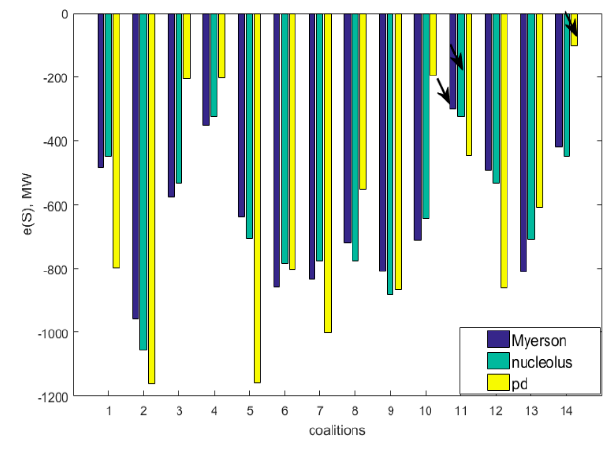
Figure 5. Coalitions’ excess and the unhappiest coalition (arrow) under the three payoff vectors.